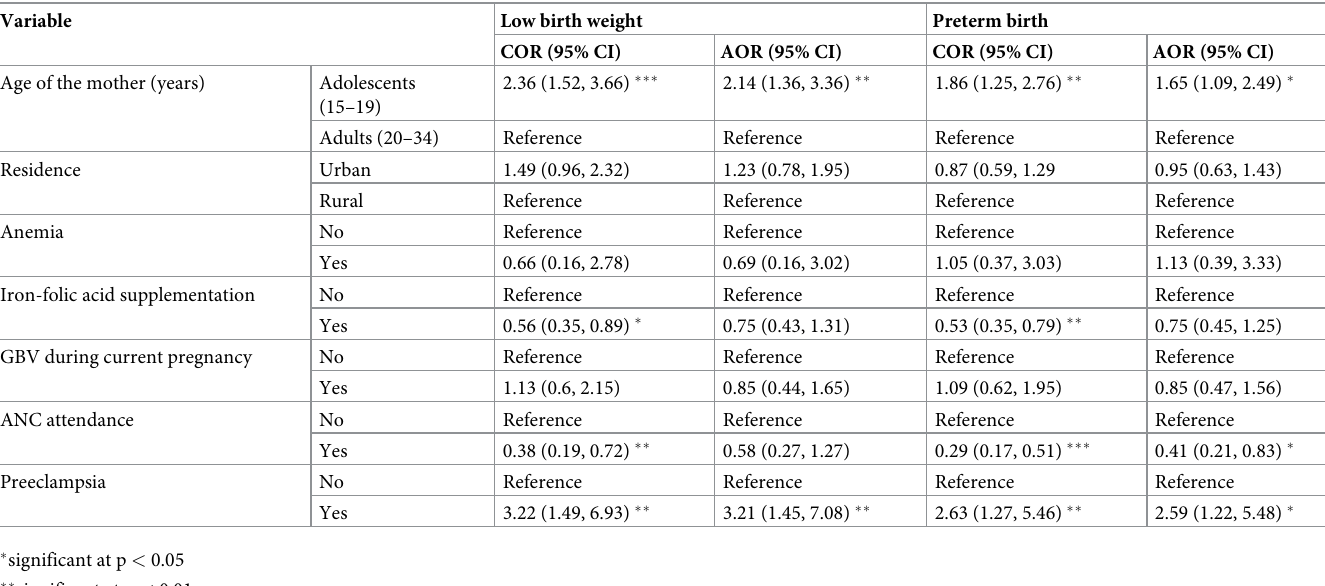
Table 4. Determinants of selected poor neonatal outcomes associated with adolescent pregnancy in Northwest Ethiopia, 2018.